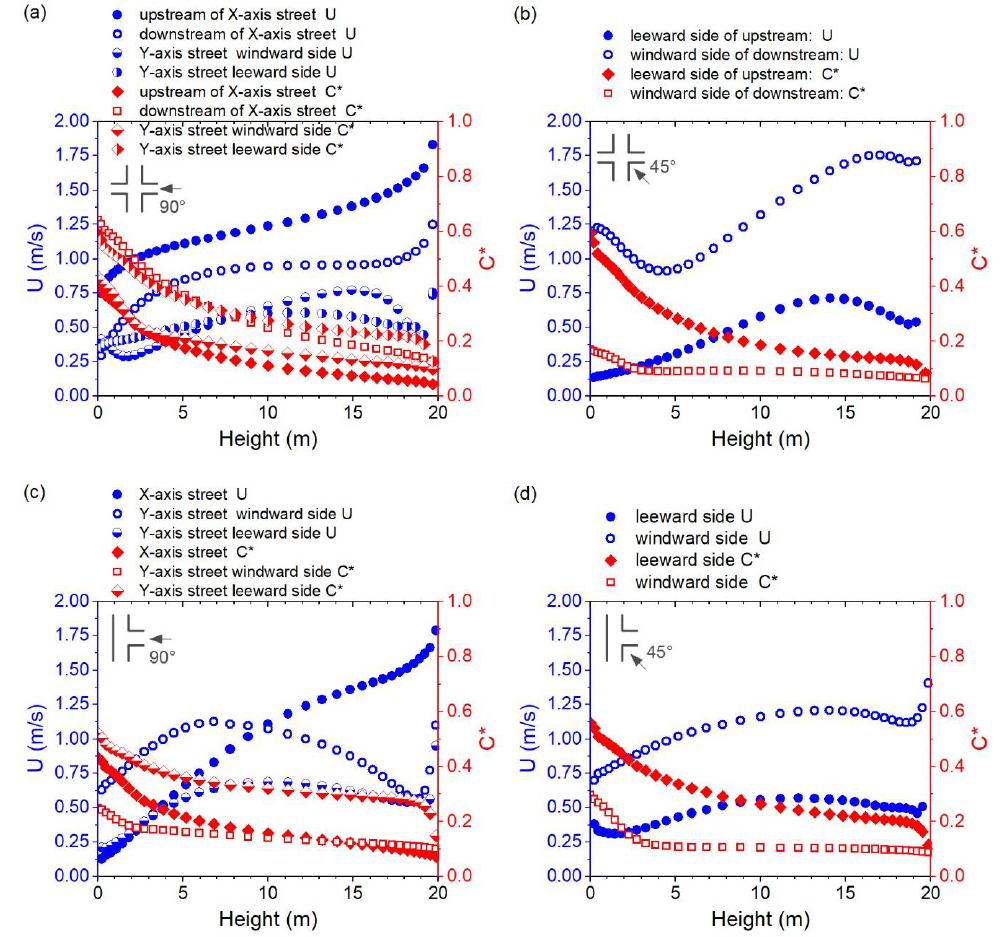
Figure 8. Vertical distribution of wind velocity (U) and normalized pollutant concentration (C*) for the near-wall surfaces in Cases ( a ) B-90, ( b ) B-45, ( c ) C-90, and ( d ) C-45.